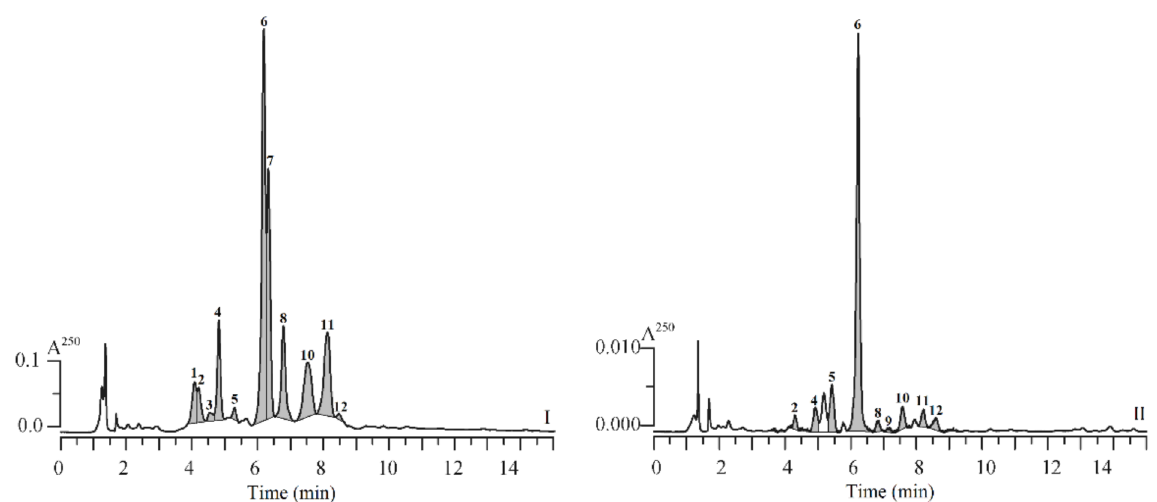
Figure 1. High-performance liquid chromatography with photodiode array detection (PDA: 250 nm) of S. repens SPE-1 frac- tions: leaves, I and roots, II (control 1 sample). Compounds: 1 —26-hydroxyintegristerone A; 2 —20,